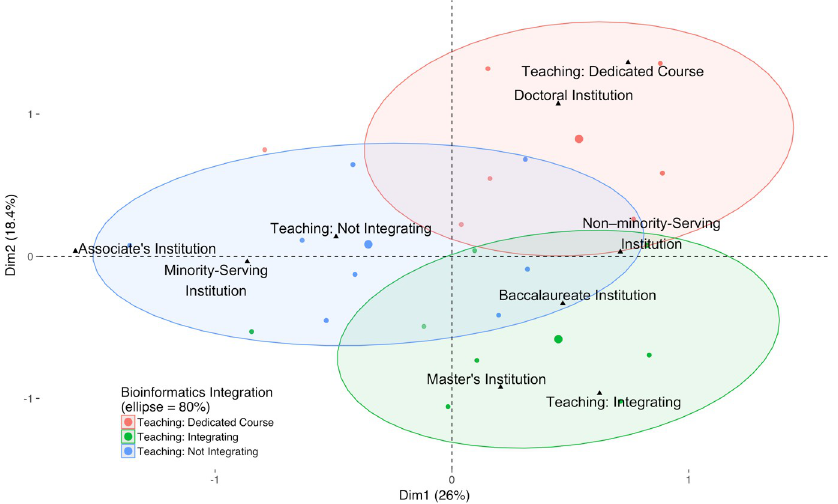
Fig 9. Multiple correspondence analysis of respondents by integration of bioinformatics, Carnegie Classification, and institutional minority-serving status. Multiple correspondence was calculated grouping faculty by their level of bioinformatics teaching: teaching a dedicated bioinformatics course (Teaching: Dedicated Course), integrating bioinformatics into existing courses (Teaching: Integrating), and not teaching bioinformatics (Teaching: Not Integrating). (See Fig 5 and Materials and Methods.) Here, the Carnegie Classification of the respondent’s institution, illustrated with an upward triangle ( ▲ ), was used as the predicted qualitative supplementary factor. The plot reveals that correlations between institution type and the level of bioinformatics teaching separate faculty into three distinct populations. For example, teaching a dedicated course in bioinformatics tends to be associated with doctoral-granting institutions and integrating bioinformatics into existing courses is associated with master’s institutions; faculty at associate’s colleges tend not to include bioinformatics in their teaching. As discussed in the narrative, faculty at minority-serving institutions face additional barriers in integrating bioinformatics, and as shown in the figure, faculty at these institutions tend not to include bioinformatics in their teaching. Only respondents who responded to all the demographic questions are shown ( n =